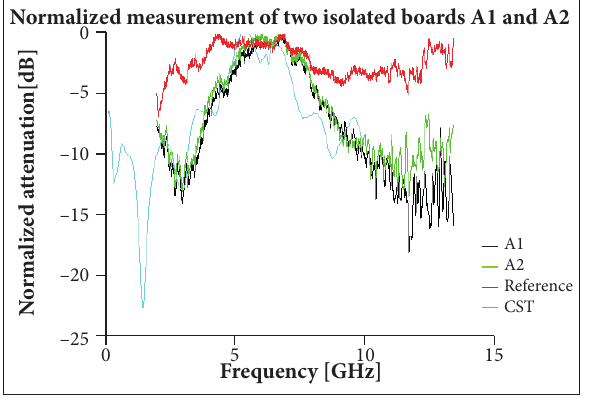
Figure 9. Measurement and simulation of the single array.